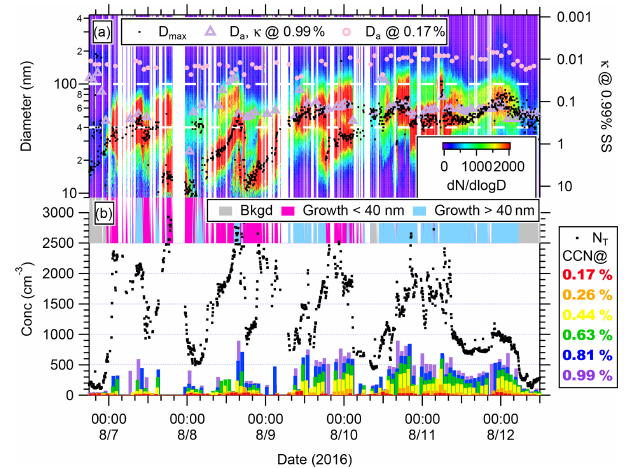
Figure 3. As in Fig. 2 but for 7–12 August 2016. D a calculated at 0.17% and 0.99% SS are included in panel (a) as well as the corresponding κ values calculated for D a at 0.99% SS.